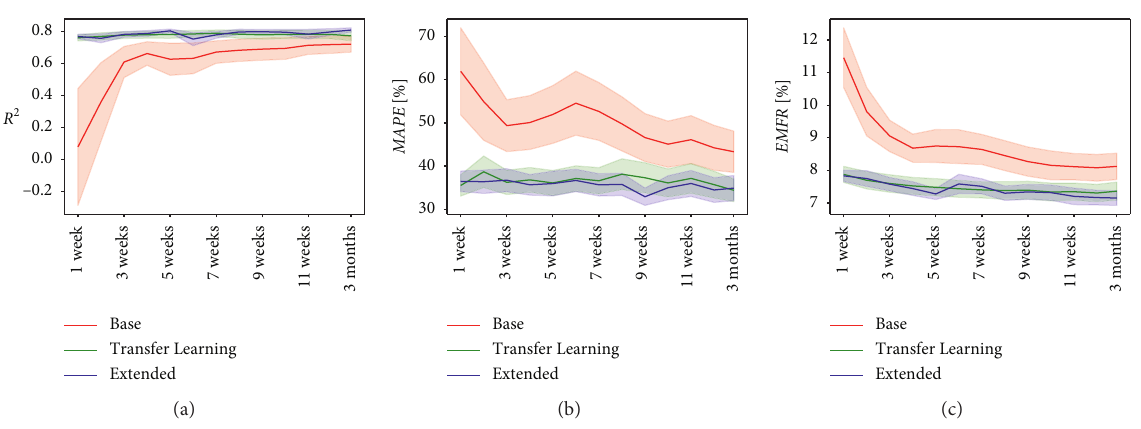
Figure 6: Mean (a) R 2 , (b) MAPE, and (c) EMFR metrics depending on the size of the